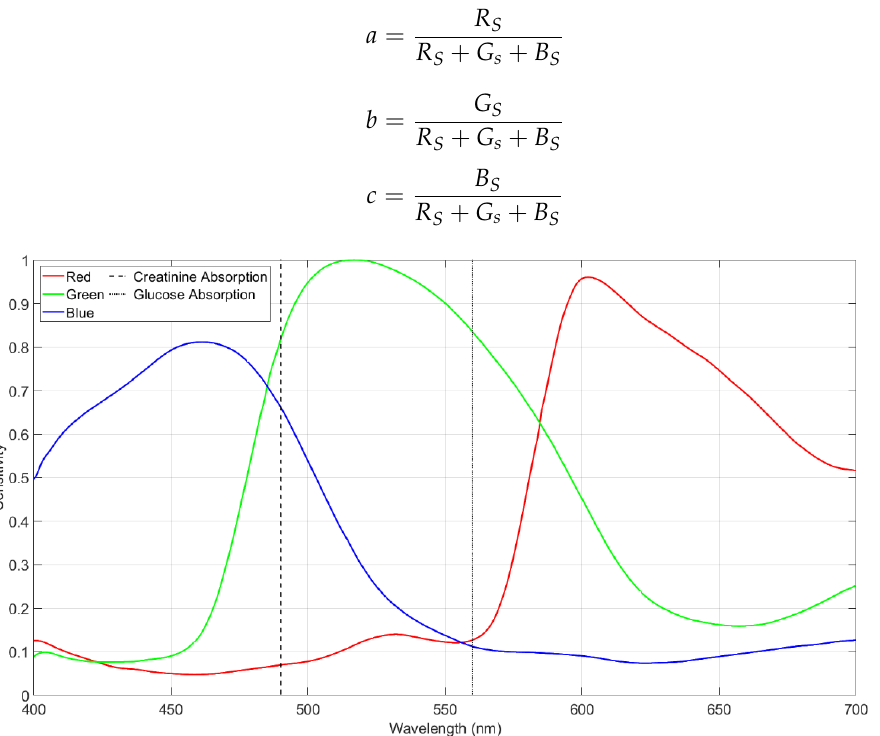
Figure 2. The Raspberry Pi SONY IMX219 camera RGB sensitivity and the absorption wavelength of the creatinine and glucose.